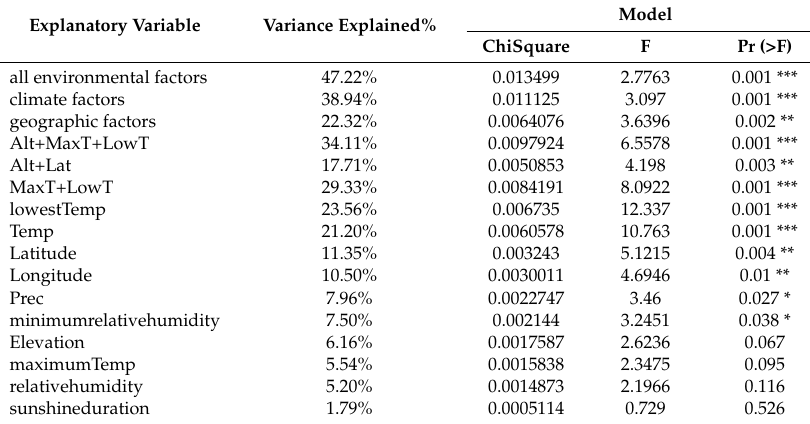
Table 5. ANOVA of key factors in CCA models.